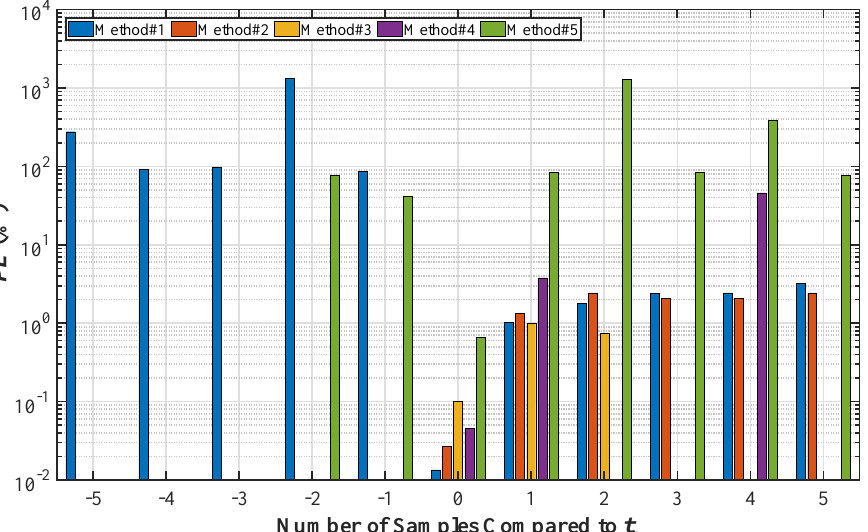
Figure 8. Impact of inaccurate event detection on the performance of the examined methods. A nega- tive sign denotes samples prior to the actual occurrence of the event. A positive sign denotes samples after the occurrence of the event. Note that results are illustrated using a logarithmic